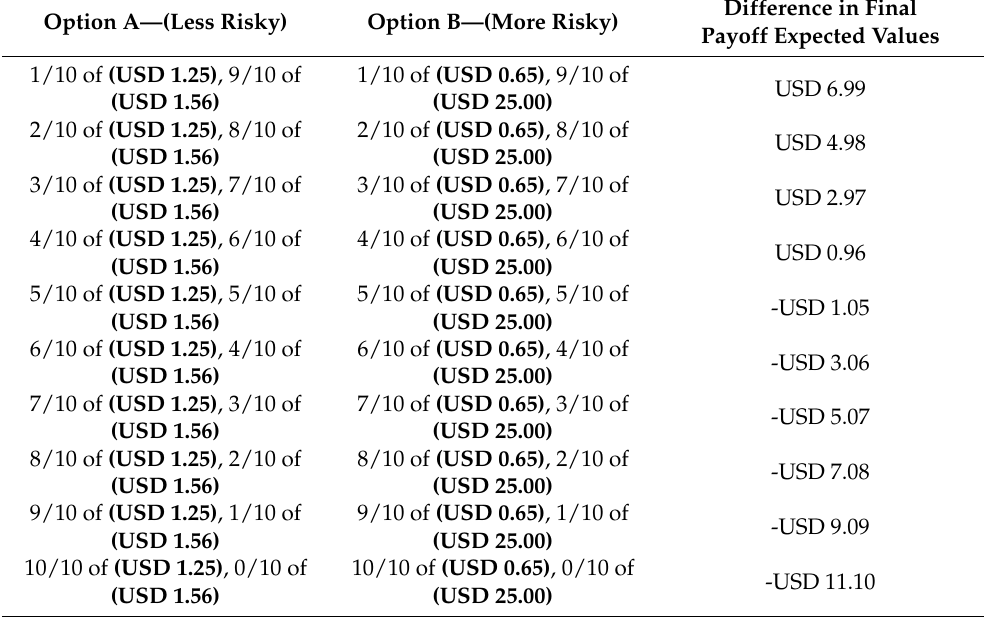
Table A1. Price-based lotteries along with their corresponding final payoff expected